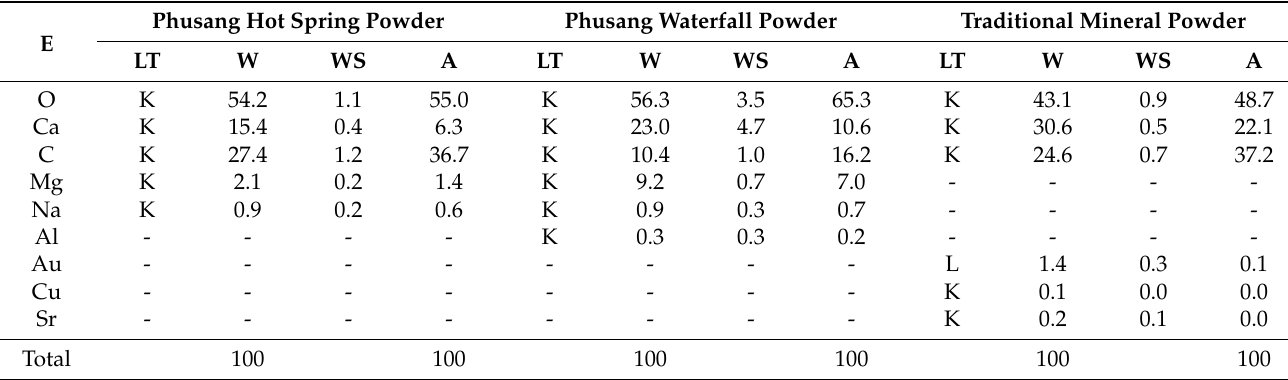
Figure 3. Traditional mineral powder at 180 ◦ C. Table 3. EDS analysis of mineral